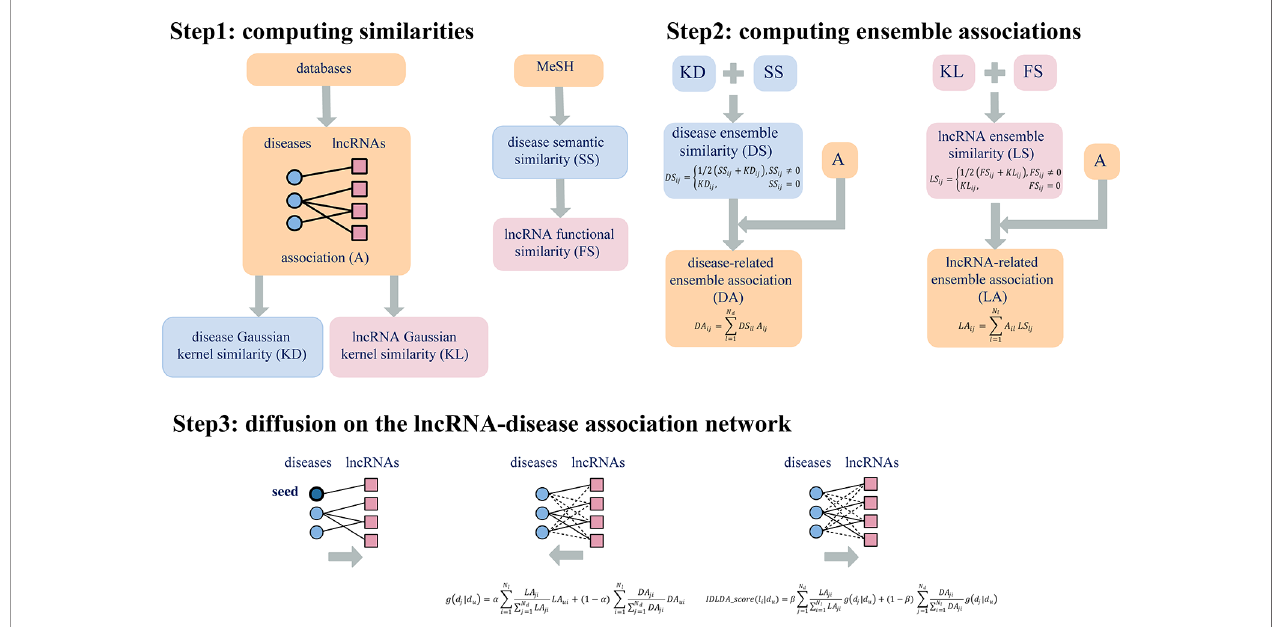
FIGURE 2 | Flowchart of IDLDA. N d and N l represent the number of diseases and the number of lncRNAs,